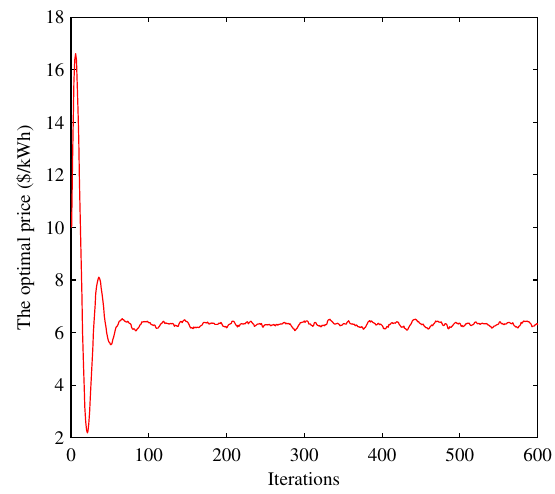
Figure 12. Convergence of the retail price under case